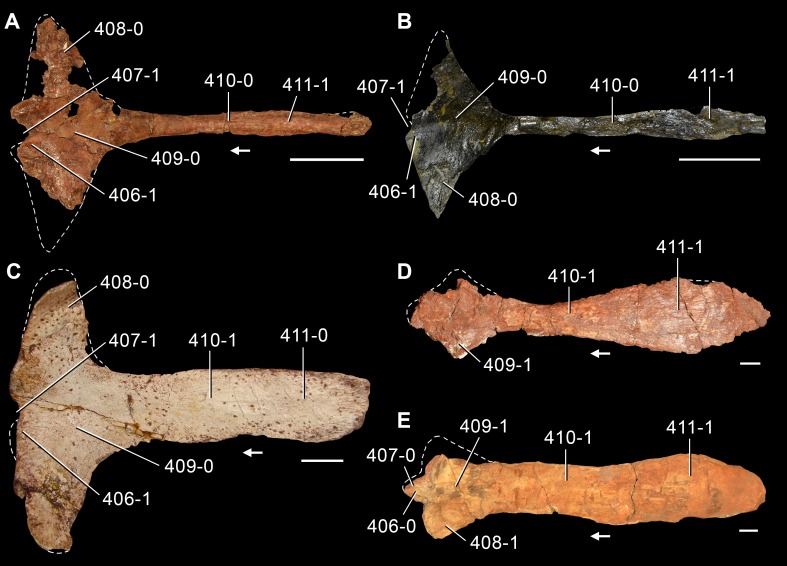
Interclavicles of Triassic archosauromorphs in ventral view.(A) Prolacerta broomi (BP/1/2675); (B) Tasmaniosaurus triassicus (UTGD 54655); (C) Proterosuchus fergusi (GHG 363); (D) Garjainia prima (PIN 2394/5-34); and (E) Parasuchus hislopi (ISI R42). Numbers indicate character-states scored in the data matrix and the arrows indicate anterior direction. Scale bars equal 1 cm.